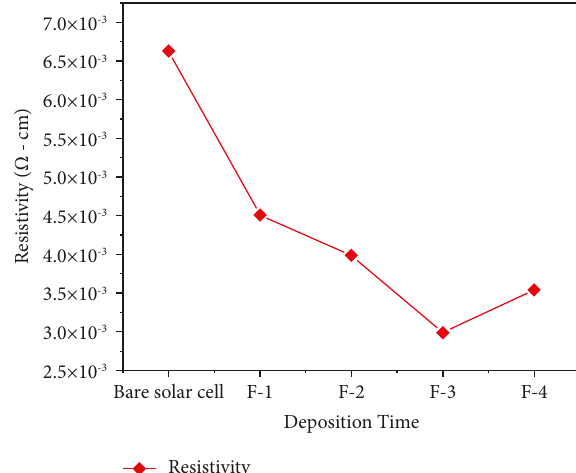
Figure 9: Electrical resistivity of coated